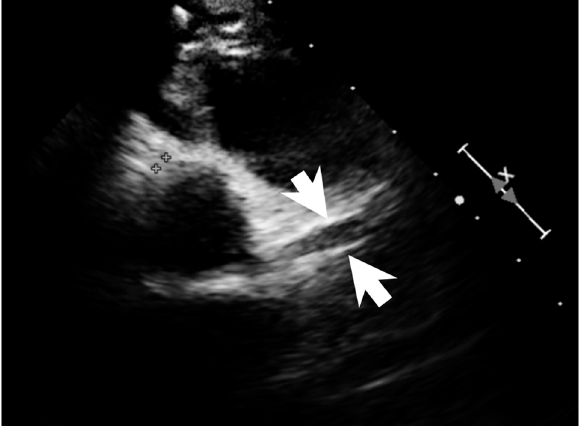
Figure 4. Coronary dilatation of LCA on the echocardiography (arrows).